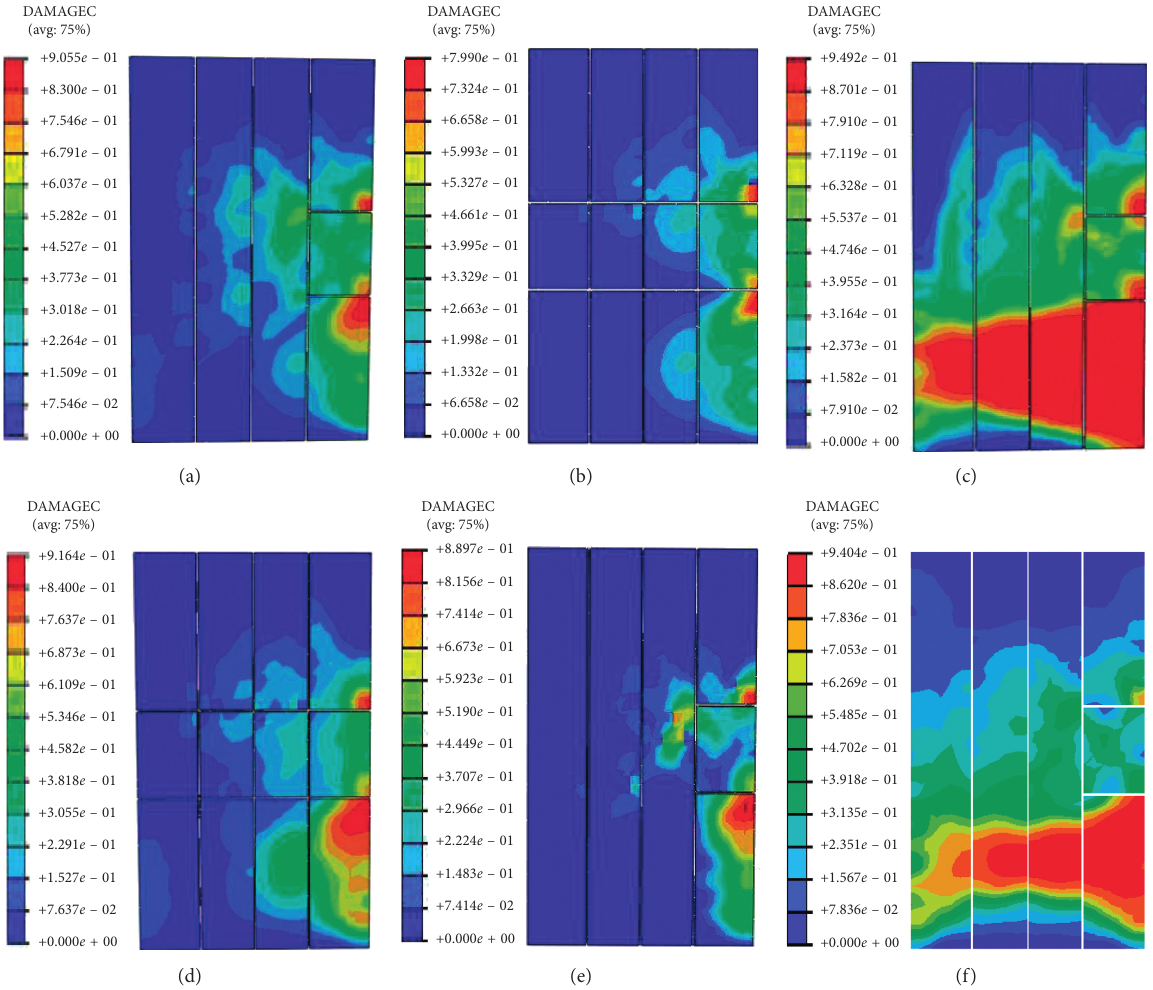
Figure 12: Compressive damage of concrete at 4 Δ y . (a) PEC-1. (b) PEC-2. (c) PEC-3. (d) PEC-4. (e) PEC-5. (f)